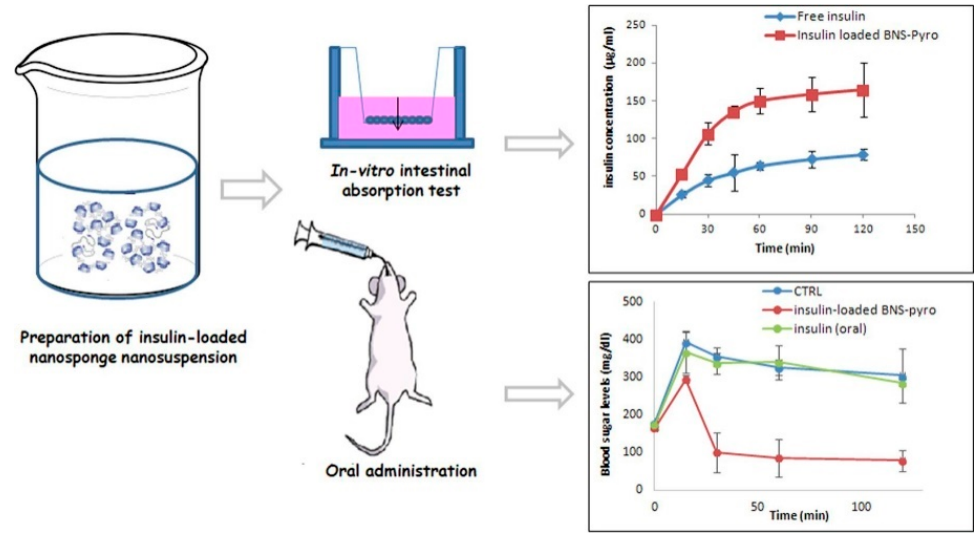
Figure 4. Schematic Insulin case study with the results obtained of absorption ( upper ) and blood glucose concentration ( lower ). Obtained from [21] with permission.